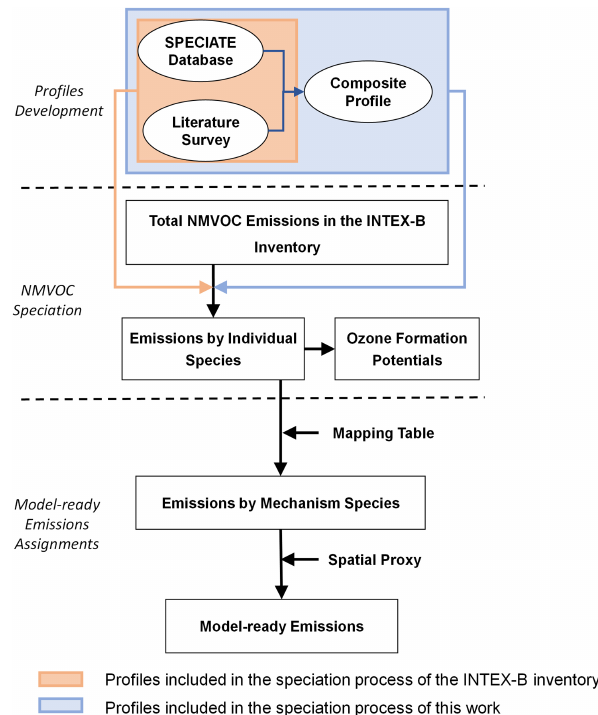
Figure 1. Schematic methodology of this